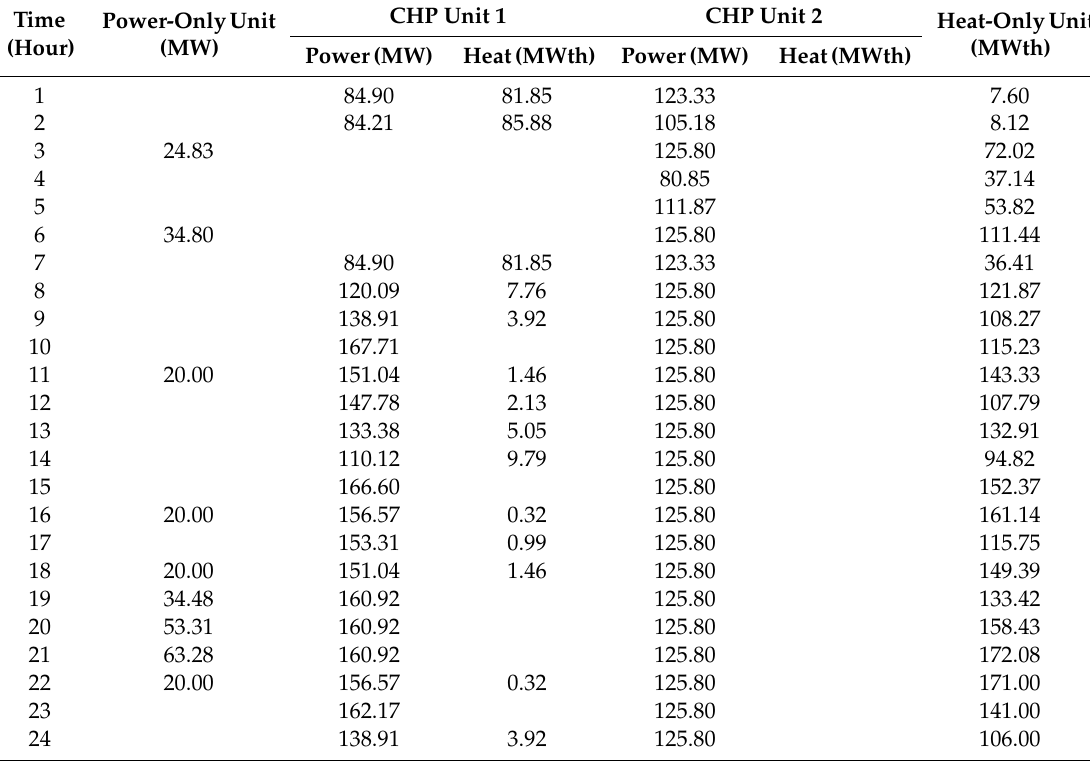
Table 11. Optimal generation of the units.